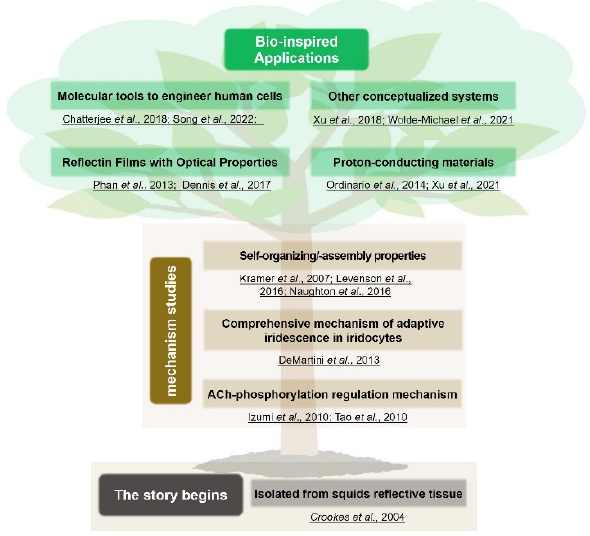
Figure 1. Timeline and roadmap for reflectin-associated studies, including their initial component identification, fundamental studies about their working mechanism, and novel inspiring bio-inspired applications [5,13,18,19,25,26,32–36,38–41]. Copyright 2007, Nature Publishing Group. Cop-